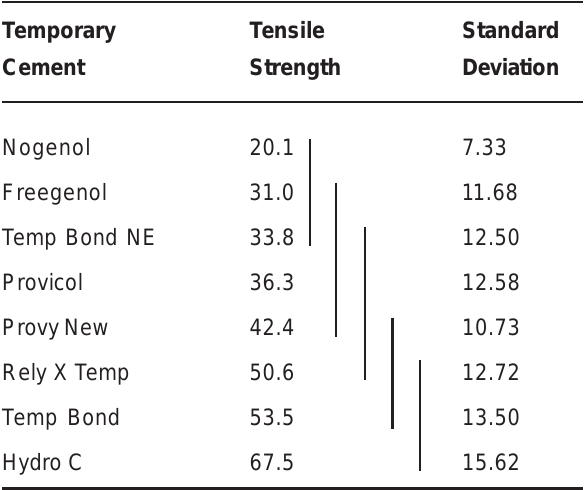
Groups connected with vertical lines are not significantly different (p>0.05)